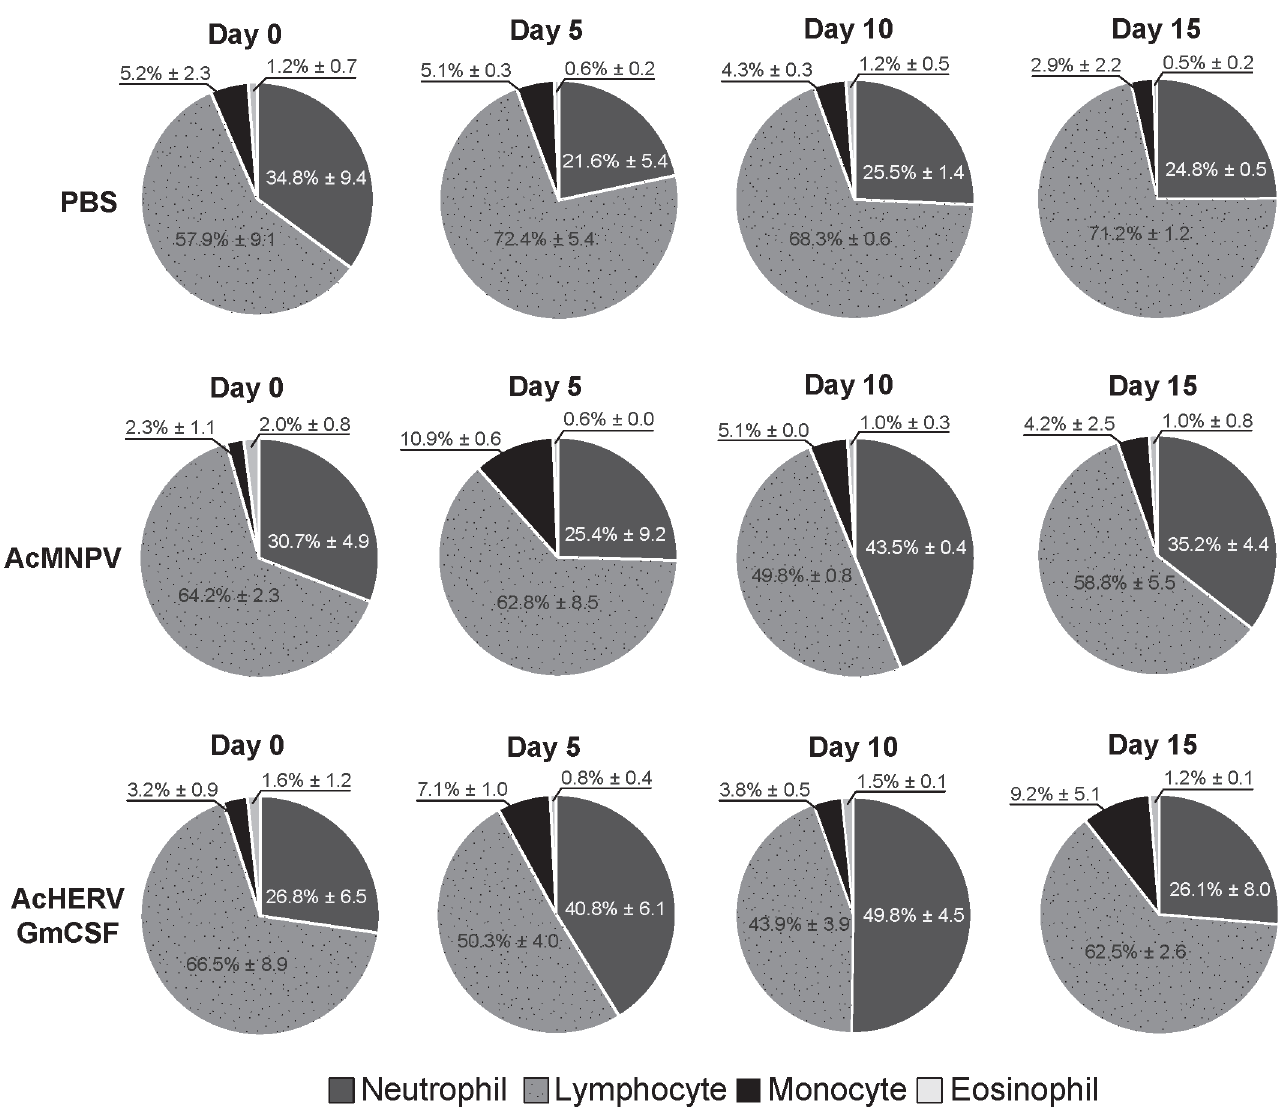
Fig 2. Hematological analysis of changes in white blood cell composition. Two samples (2/2) of blood from mice immunized with AcMNPV or AcHERV-GmCSF, or control mice injected with PBS, were collected from the jugular vein at 5-day intervals, and hematological analyses were performed. Neutrophils, dark gray; lymphocytes, dotted gray; monocytes, black; eosinophils, gray. Data were presented as mean percentage of leukocyte ± SD and pie graphs are presented mean percentage of